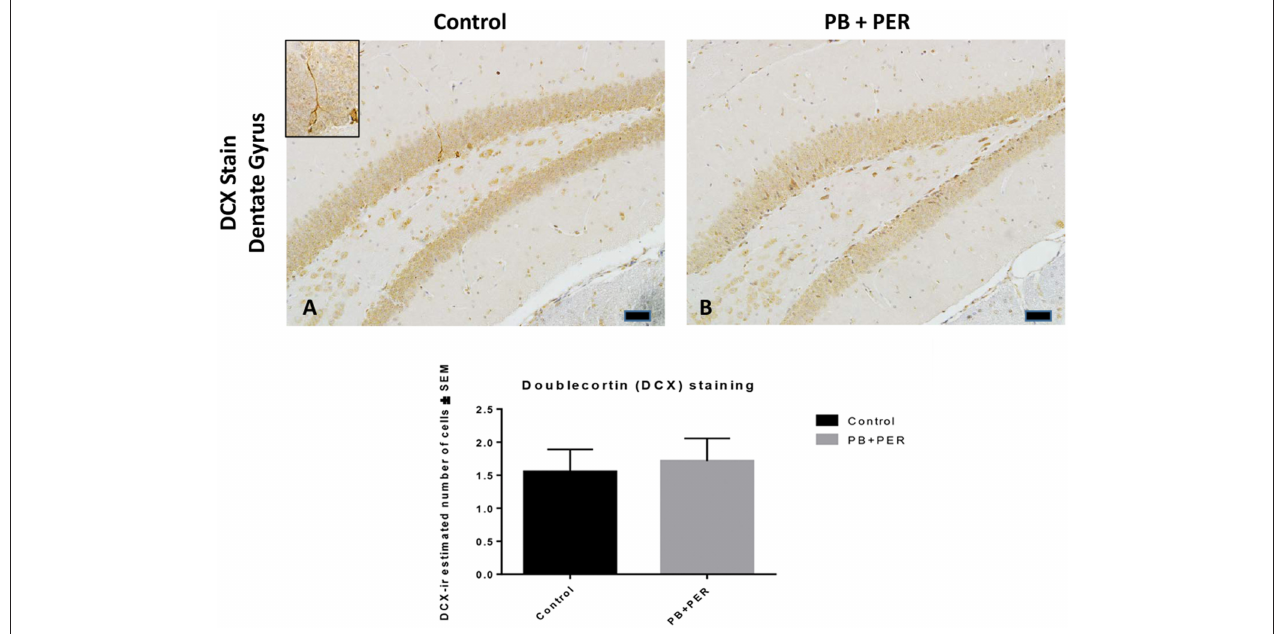
FIGURE 10 | No differences were observed in neurogenesis in mice, 22.5 months post exposure. PB + PER exposure did not alter neurogenesis in the dentate gyrus (DG) region in exposed animals at 22.5 months post exposure (B) as compared to controls (A) . The depicted micrographs were taken using 20X (A,B) , scale bars represent 50 µ m. Histograms depict the manual quantification of the doublecortin (DCX) stain in the dentate gyri, as total number of cells within the